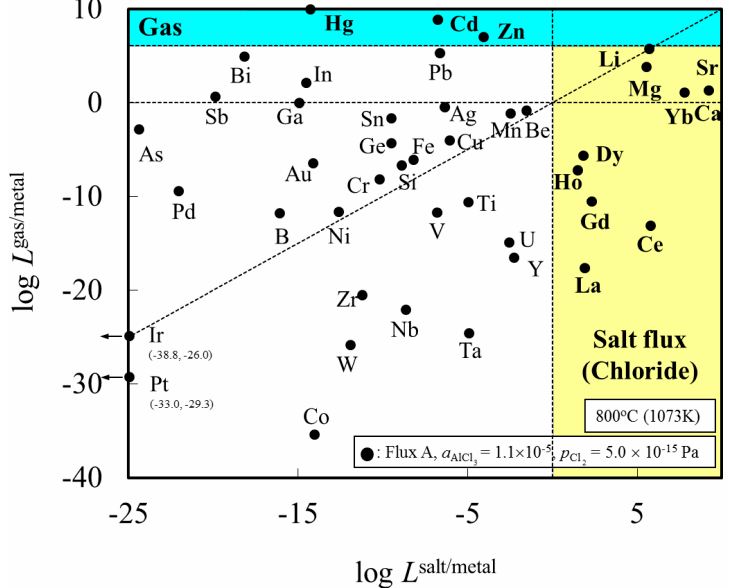
Figure 3. Distribution chart of elements among gas, salt flux (chloride), and metal phases under the simulated atmosphere of the aluminum melting